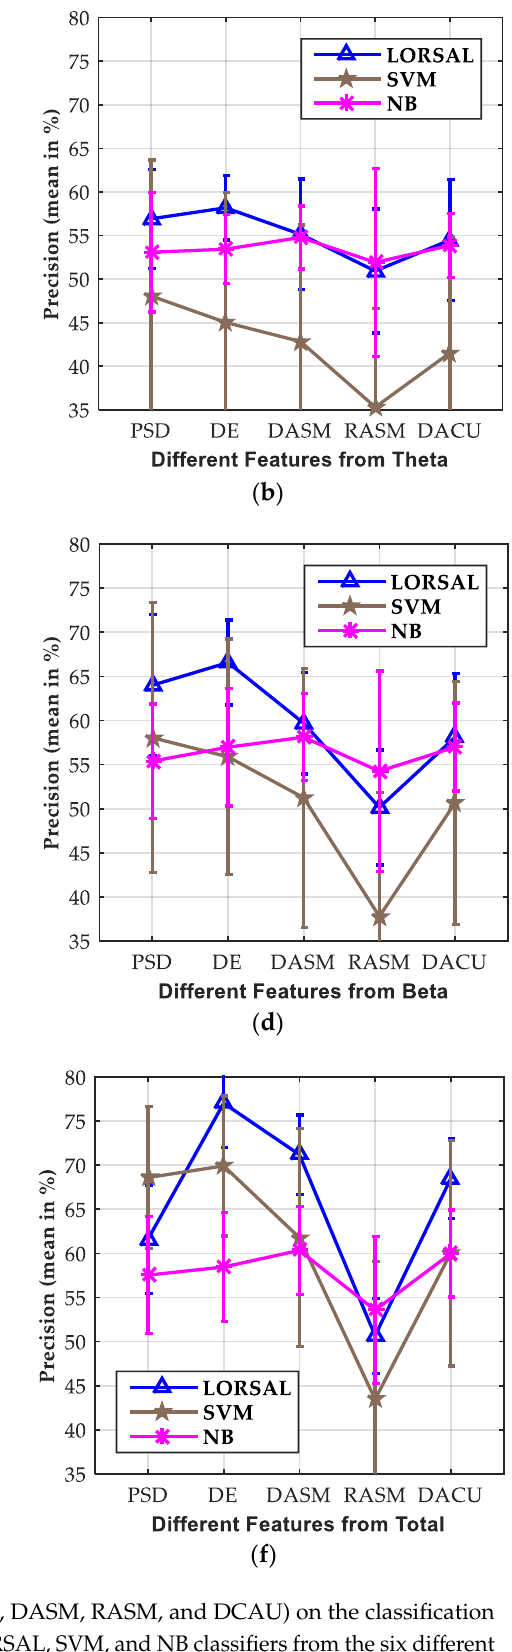
Figure 7. Effects of the different features (PSD, DE, DASM, RASM, and DCAU) on the classification precisions for LV/HV emotions obtained by the LORSAL, SVM, and NB classifiers from the six different frequency bands: ( a ) Delta, ( b ) Theta, ( c ) Alpha, ( d ) Beta, ( e ) Gamma, ( f ) Total.